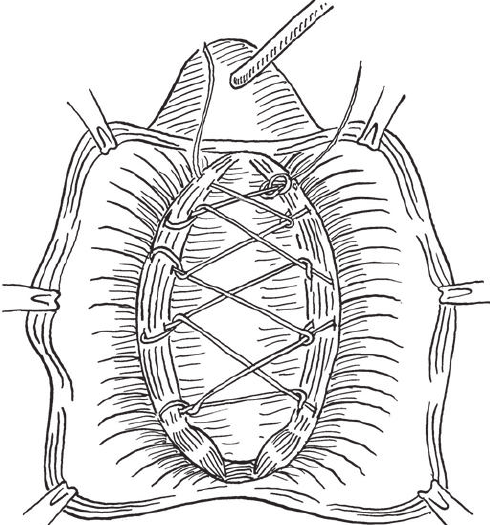
Figure 2: The suture was extended continuously to the distal aspect to form a darn.